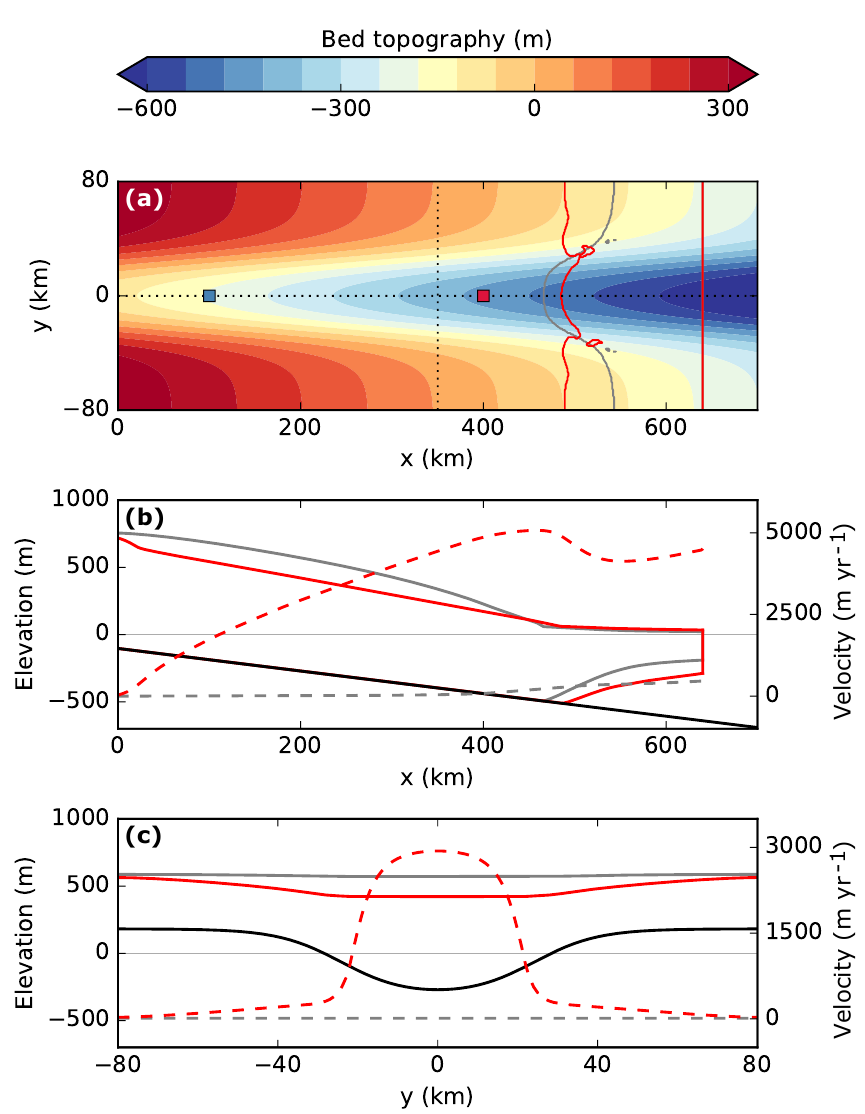
Figure 1. (a) Bed topography prescribed in the experiments (color bar) with contours of grounding line and calving front during buildup (gray) and surge (red; see corresponding circles in Fig. 3). Note that throughout this study we focus on the right-hand half of the symmetric model domain as shown here (symmetry axis at x = 0). Dotted lines mark locations of the cross sections shown in the other two panels. (b) Cross section in x direction along the centerline of the model domain. Profiles of the ice sheet (straight lines) and its velocity (dashed) are shown for the buildup phase (gray) and during surge (red); bed topography is in black. (c) Cross section in y direction across the model domain at x = 350km. Same colors as in panel (b) . Red and blue squares on the centerline denote locations of two point measurements for which time series are shown in Figs. A1 and